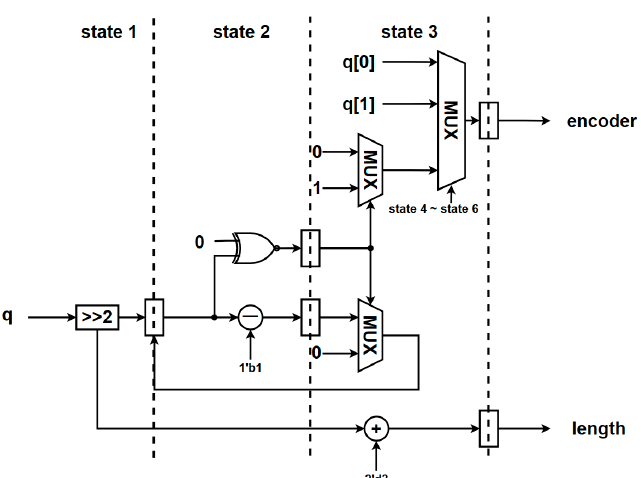
Figure 12. The architecture of the Golomb–Rice coder module. State 1 to State 3 are calculating the quantization value and coding. State 4 to 6 are controlling the output value about encoder.